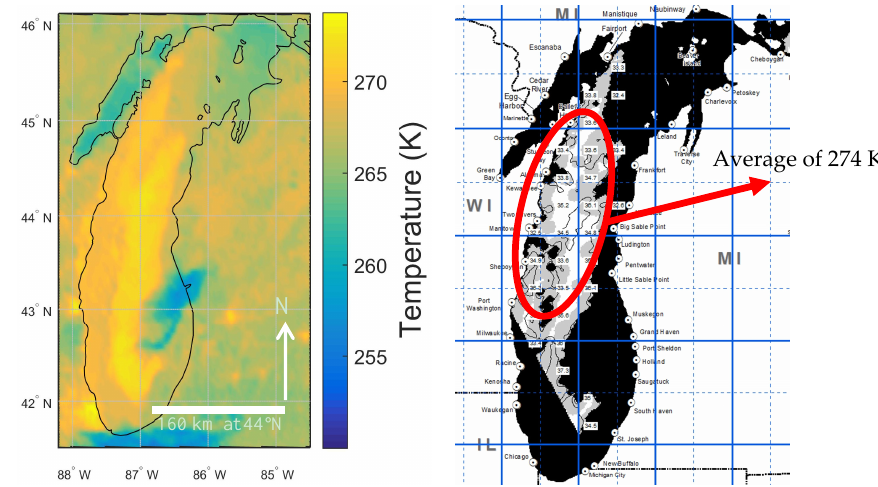
Figure 5. ST of Lake Michigan on 28 February 2015: ( left ) ST at 1730 UTC; ( right ) surface temperature map at 1754 UTC from Coastwatch at Michigan State University.